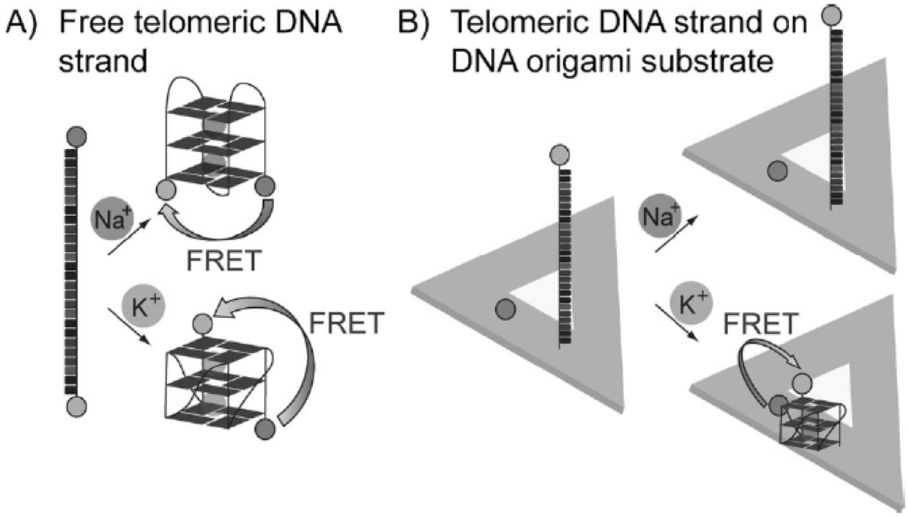
Figure 4. Selective detection of K + with telomeric DNA strand and DNA origami. ( A ) Free telomeric DNA strand; ( B ) Telomeric DNA strand on DNA origami substrate (Reprinted with permission from [146], published by WILEY-VCH Verlag GmbH & Co.,